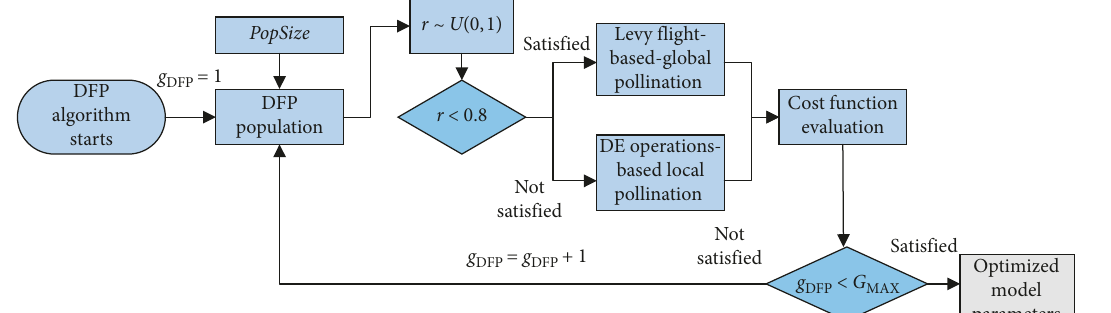
Figure 5: The DFP optimization algorithm. Note: G MAX denotes the maximum number of generations. U (0, 1) is a uniform number generator. r denotes a random number generated from U (0,1). g DFP is the index of the current